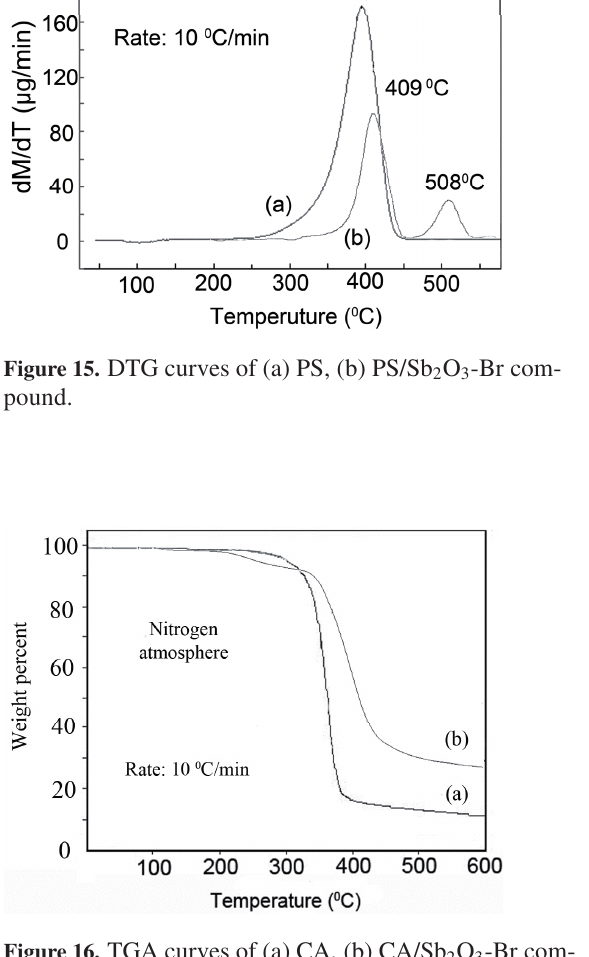
Figure 16. TGA curves of (a) CA, (b) CA/Sb 2 O 3 -Br com- pound.